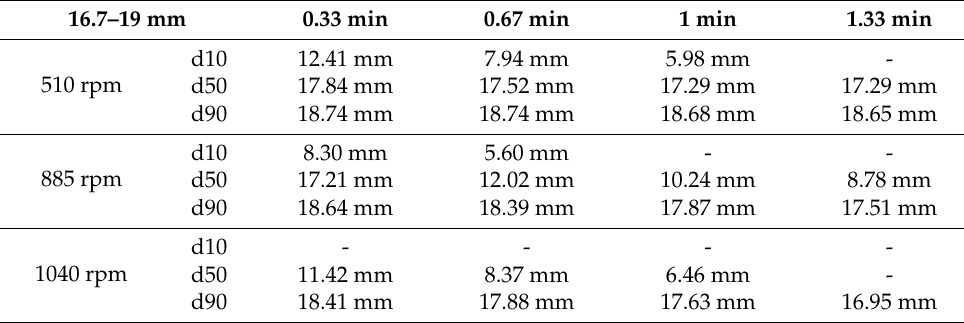
Table 6. d 10 , d 50 , and d 90 of the 16.7–19.0 mm particles.